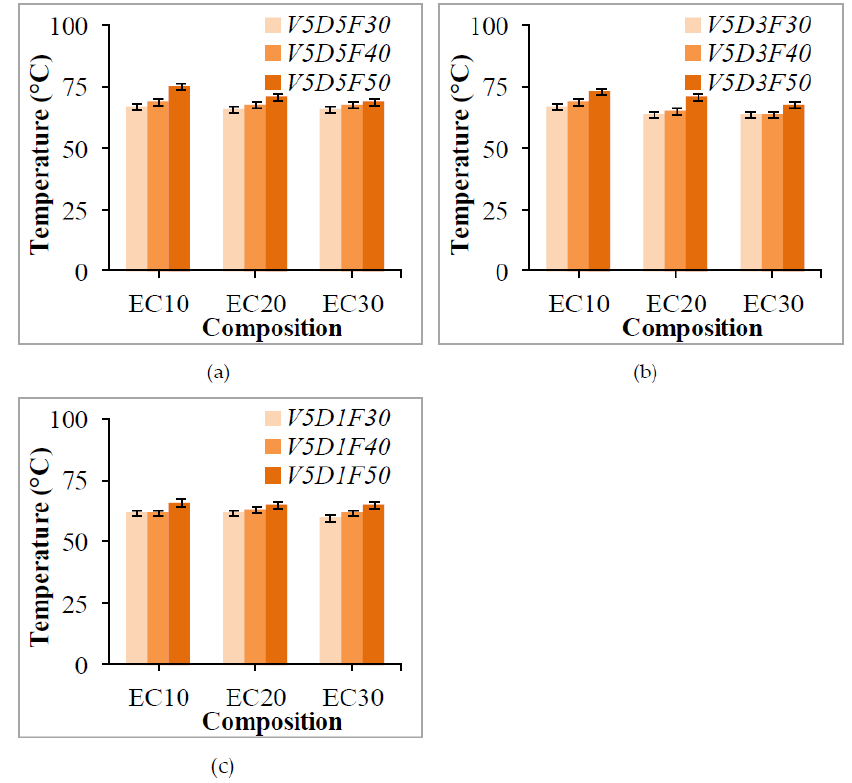
Figure 8. Disc temperature measured post-test at different sliding distances ( a ) 5 km ( b ) 3 km and ( c ) 1 km.